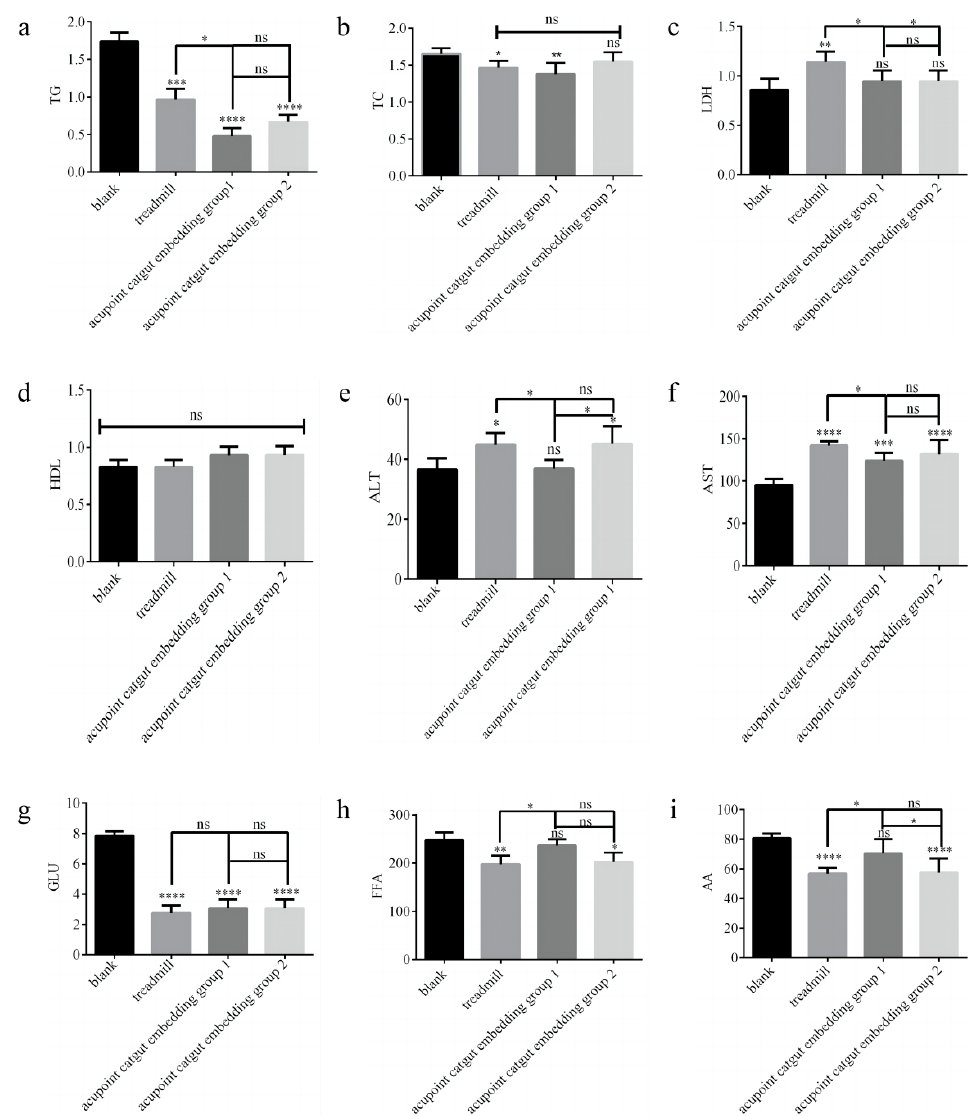
Figure 8. Biomarkers of lipid metabolism in the blood. ( a ) TG, ( b ) TC, ( c ) LDH, ( d ) HDL, ( e ) ALT, ( f ) AST, ( g ) GLU, ( h ) FFA, and ( i ) AA. * p < 0.05, ** p < 0.01, *** p < 0.001, **** p < 0.0001; ns: not significant ( p > 0.05). TG: triglyceride; TC: total cholesterol; LDH: lactate dehydrogenase; HDL: high-density lipoprotein; ALT: alanine transaminase; AST: aspartate aminotransferase; GLU: glucose; AA: arachidonic acid; and FFA: free fatty acid.